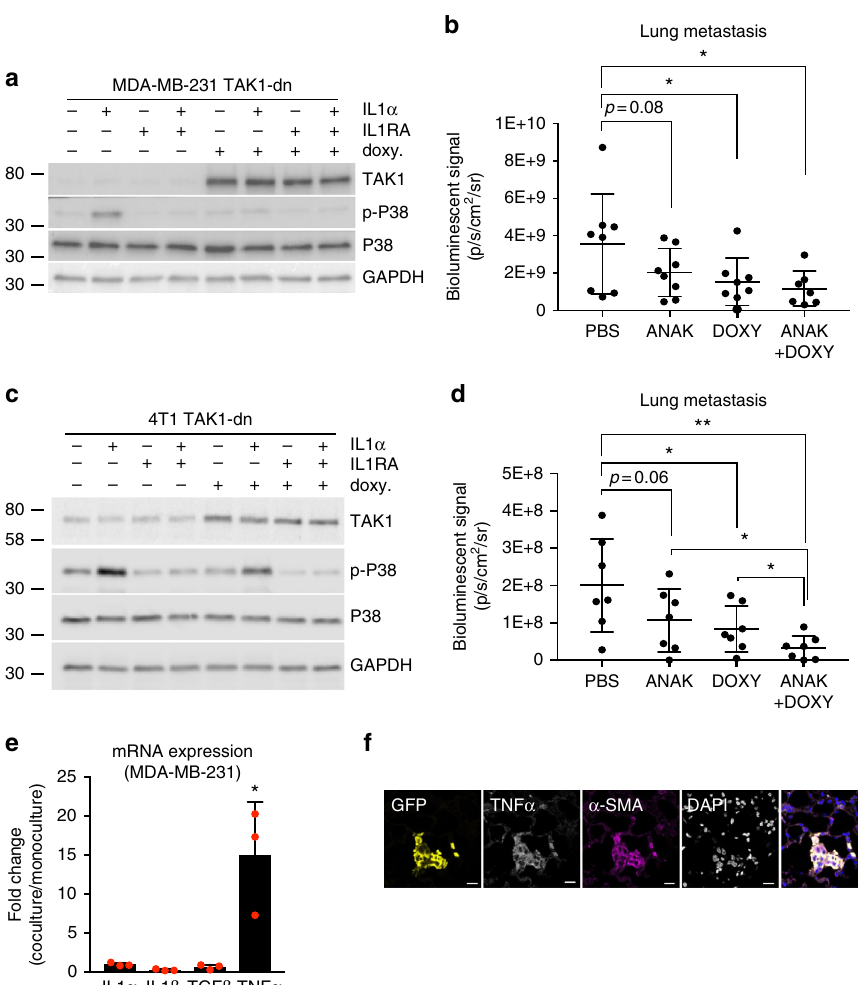
Fig. 5 Treatment with anakinra could reduce lung metastasis, but less so than TAK1 inhibition. a , c Changes in P38 phosphorylation levels in response to IL1 α (10 ng/ml) in MDA-MB-231 cells ( a ) and 4T1 cells ( c ) overexpressing doxycycline-inducible dominant-negative TAK1 (TAK1-dn) with or without treatment of doxycycline and recombinant IL1RA (100 ng/ml). Representative examples of three experiments are shown. b , d Lung metastatic burden determined by measuring the bioluminescent signal in mice injected with MDA-MB-231 ( b ) and 4T1 ( d ) cells overexpressing doxycycline-inducible TAK1- dn and with or without treatment with doxycycline and/or anakinra. Bioluminescence was measured 4 and 3 weeks after tail vein injection of MDA-MB-231 and 4T1 cells, respectively. Scatter dot plots show means± SD of signals obtained from eight ( b ) or seven ( d ) mice per group. e qPCR analysis of IL1 α , IL1 β , TGF β , and TNF α expression in MDA-MB-231 cells cultured in the presence or absence of GFP-expressing fi broblasts for 5 days. RNA was extracted from cells separated by FACS based on GFP expression. Means ± SD of three independent experiments are shown. f Immuno fl uorescent staining of lungs dissected from mice injected with GFP and luciferase-tagged MDA-MB-231 cells. Representative examples of images taken from three immunostainings of two independent experiments are shown. GFP (yellow), myo fi broblast marker α -SMA — also expressed in MDA-MB-231 cells (magenta), TNF α (white), DAPI (gray in single channel, blue in merge image), are shown. Scale bar = 20 μ m. Statistical analyses: unpaired one-tailed Student ’ s t test ( b , d ),